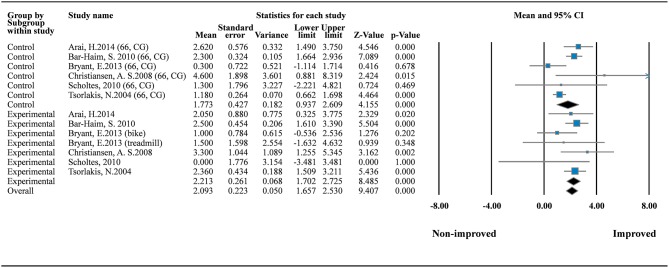
Forest plot of GMFM improvement (the GMFM-66). Control (standard care) I2 = 68.659%; Q = 15.953; df = 5. Experimental (therapeutic exercise) I2 = 0%; Q = 5.779; df = 6.